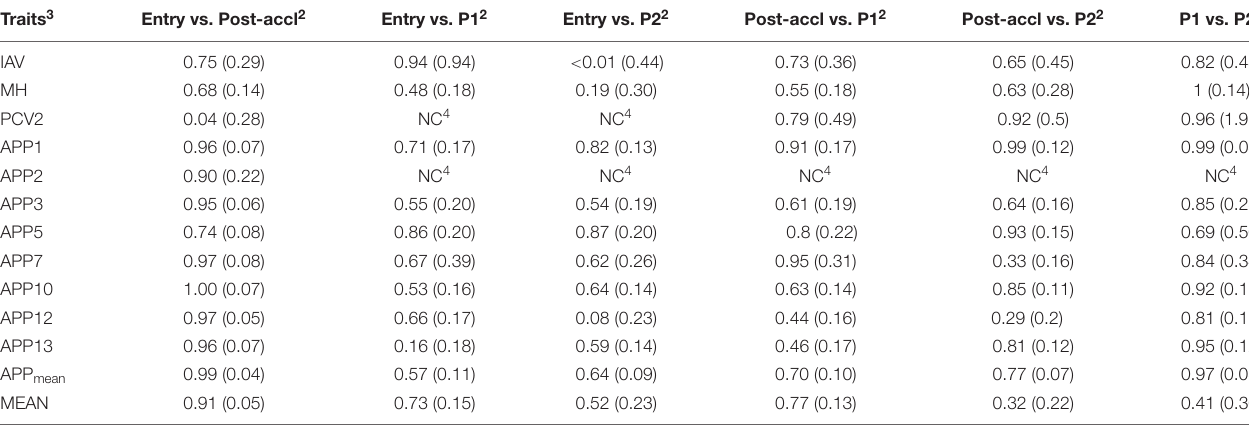
TABLE 4 | Estimates 1 of genetic correlations within antibody response to common infectious pathogens in pigs between time-points 2 . Traits